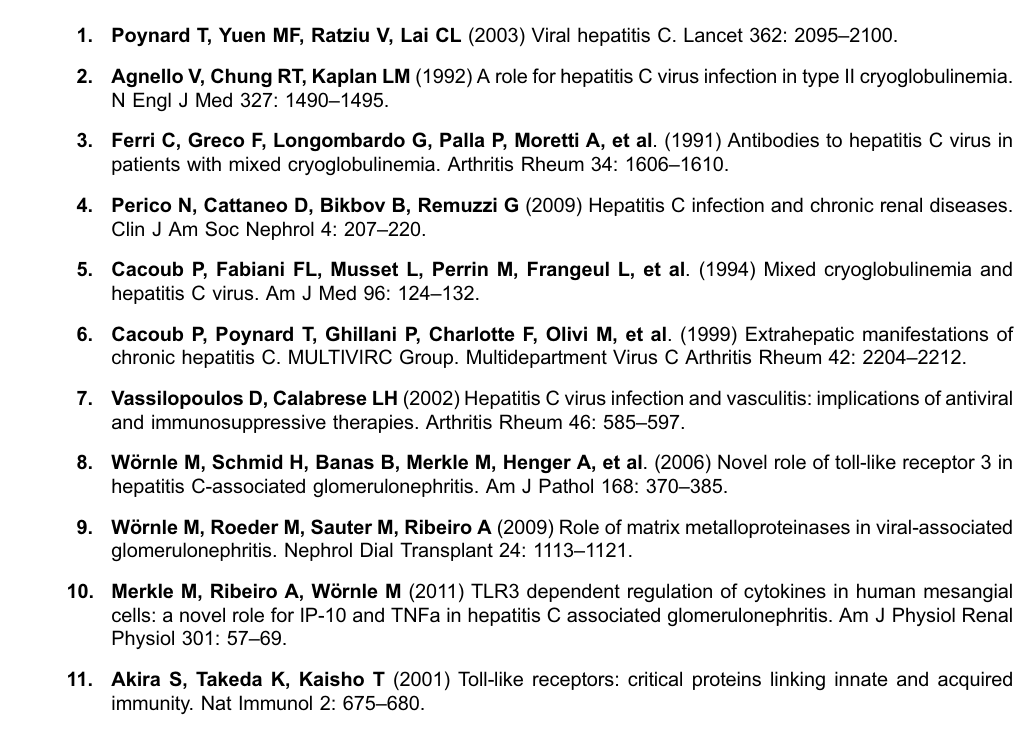
Figure S4. Amplification of poly (I:C)-dependent induction of viral receptors and TNF receptor 2 by TNF a . HMEC were grown in culture medium for 24 hours and additionally incubated in medium (basal) for different time intervals (6, 12, 24 hours) or grown in culture medium for 24 hours and additionally incubated with TNF a (TNF a ) for different time intervals (6, 12, 24 hours) or incubated with poly (I:C) for 24 hours and then grown in medium (poly (I:C)) or stimulated with TNF a (poly (I:C) + TNF a ) for different time intervals (6, 12, 24 hours). Expression of TLR3 (A), RIG-I (B) and MDA5 (C) as well as TNFR2 (D) was analyzed by RT-PCR. Results are given as means ¡ SD of three experiments done in parallel for each condition and rRNA served as the reference gene. Comparable results were obtained in two series of independent experiments. Statistically significant differences to the control are depicted with * 5 p #